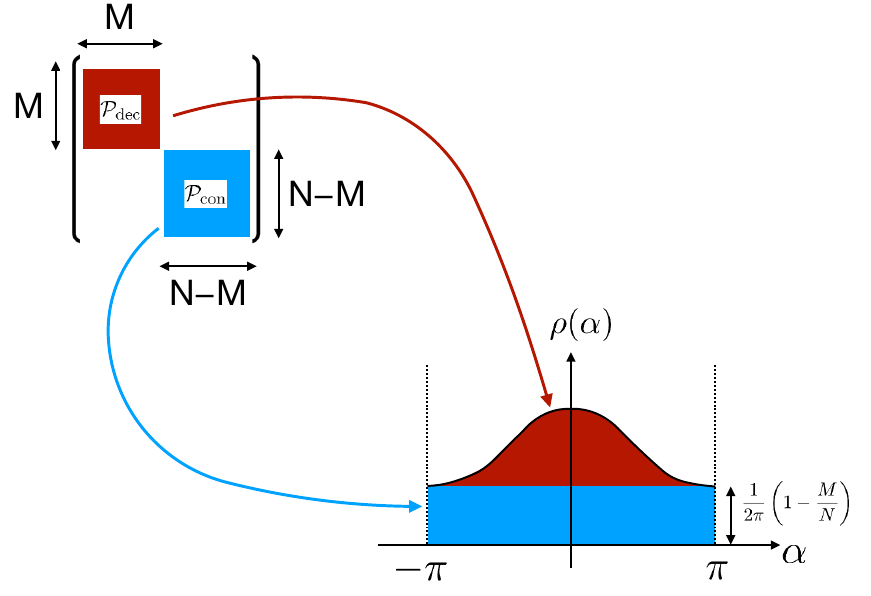
Figure 3. Sketches of the distribution of the phases of Polyakov loop in the partially-deconfined phase. Constant offset comes from the confined Polyakov loop P con while the non-uniform part comes from the deconfined Polyakov loop P dec